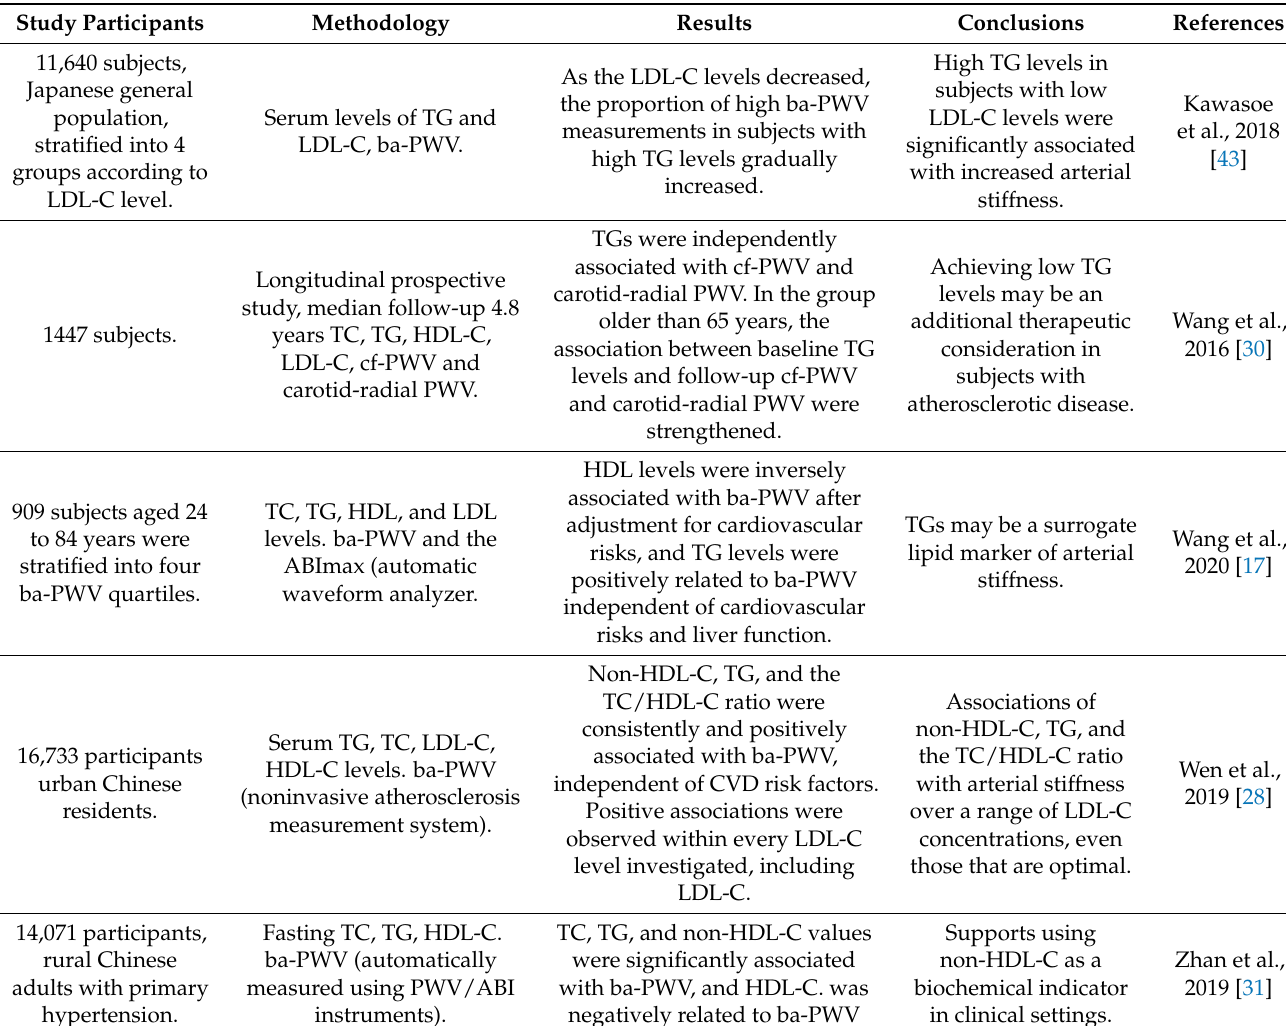
Table 1. Most relevant studies with lipid parameters and arterial stiffness (ABI =